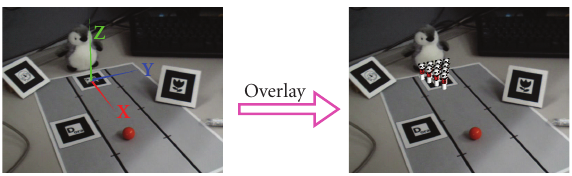
Figure 14: 3D coordinate system defined on the real lane model. Virtual pins are overlaid in this coordinate